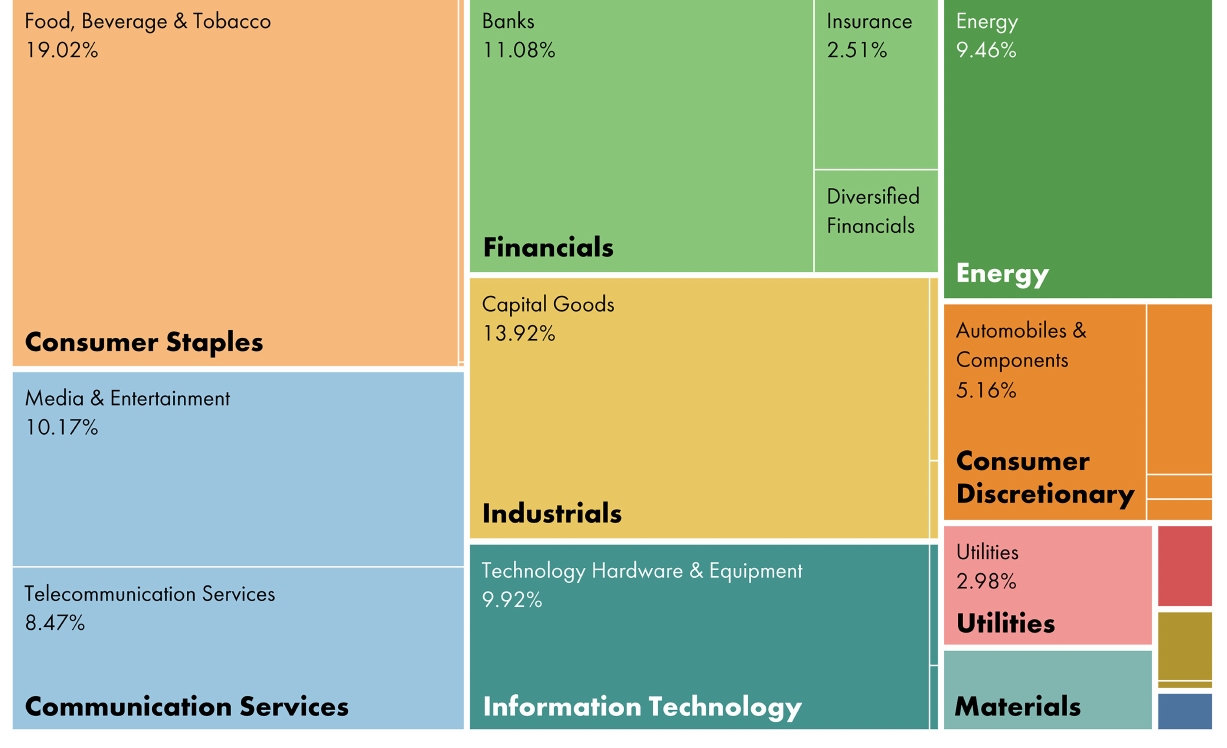
FIGURE 8 | Total ESG ownership by the industry